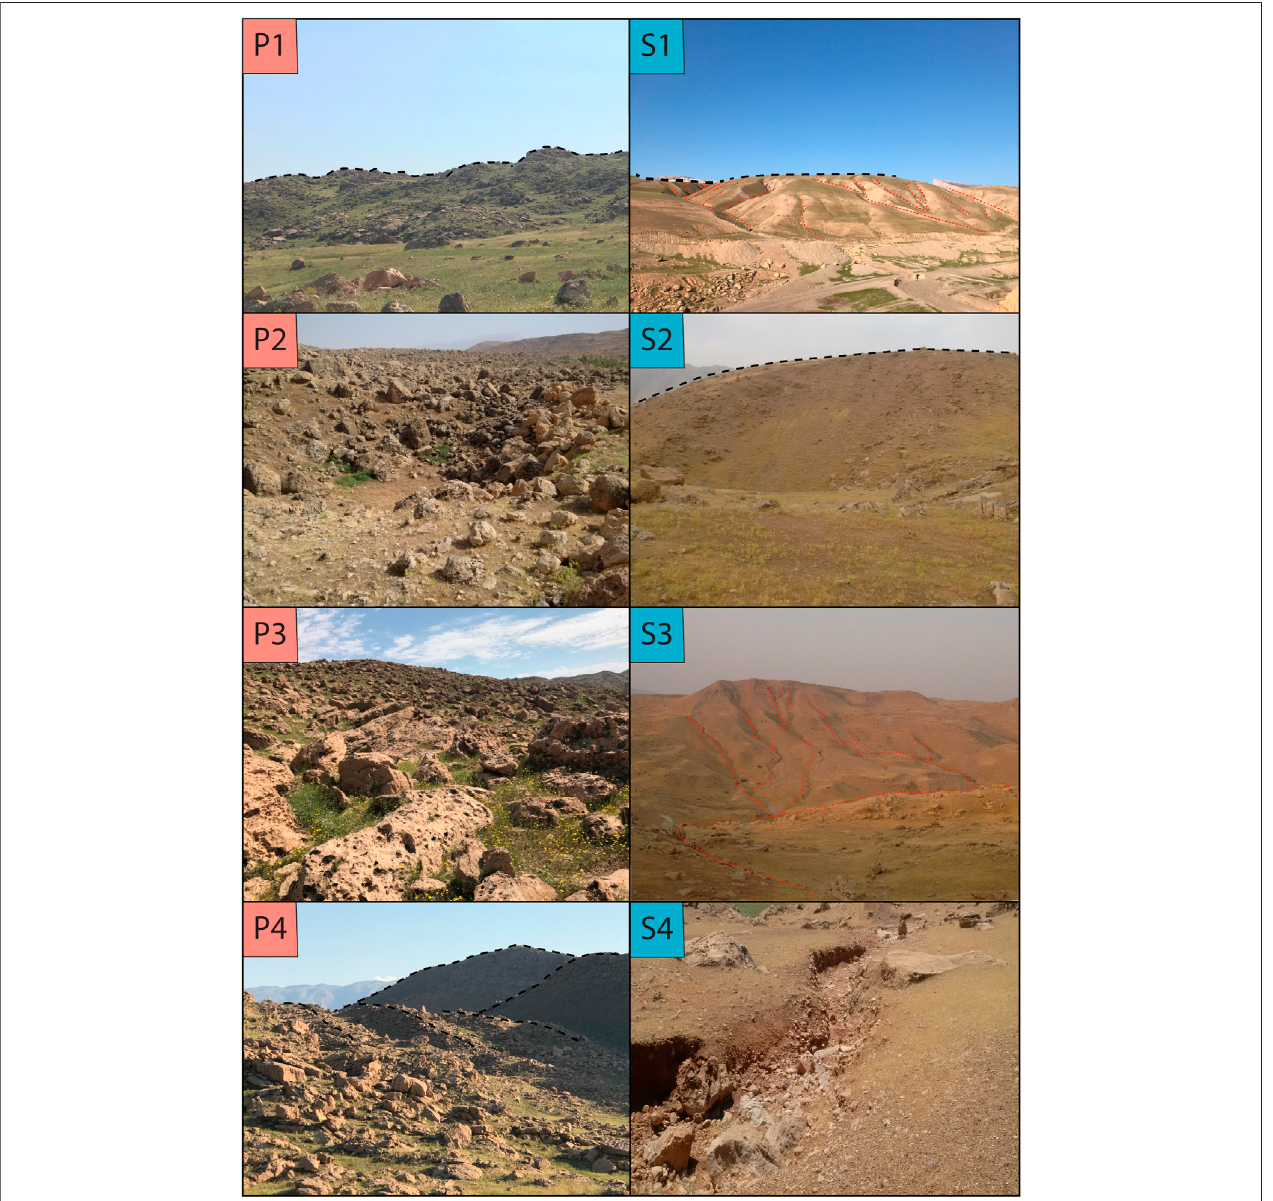
FIGURE 3 | Examples of landform combinations for the de fi nition of primary or secondary zones. P1: presence of ridges with no gullies and no blocks larger than 10 m;P2:presenceofblockswithnoevidenceofridgesandgullies;P3:presenceofblockswithnoevidenceofgulliesand ridges;P4:presenceofridgesand blockson their fl anks without evidence of gullies; S1: ridges shaped by gully erosion with no evidence of blocks; S2: combination of ridges with no blocks on their fl anks and no evidence of gullies; S3: presence of gullies with no blocks; S4: presence of gullies with no ridges.